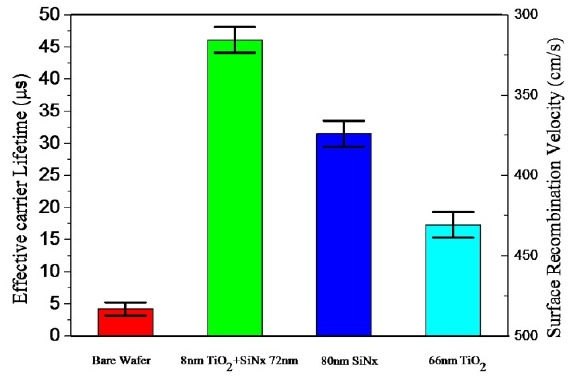
Figure 9. The average effective lifetime at the injection level 1 × 10 15 cm − 3 for bare Si wafers, TiO 2 /SiN x stacks, 80-nm-thick SiN x films by PECVD, and 66-nm-thick TiO 2 films by ALD.